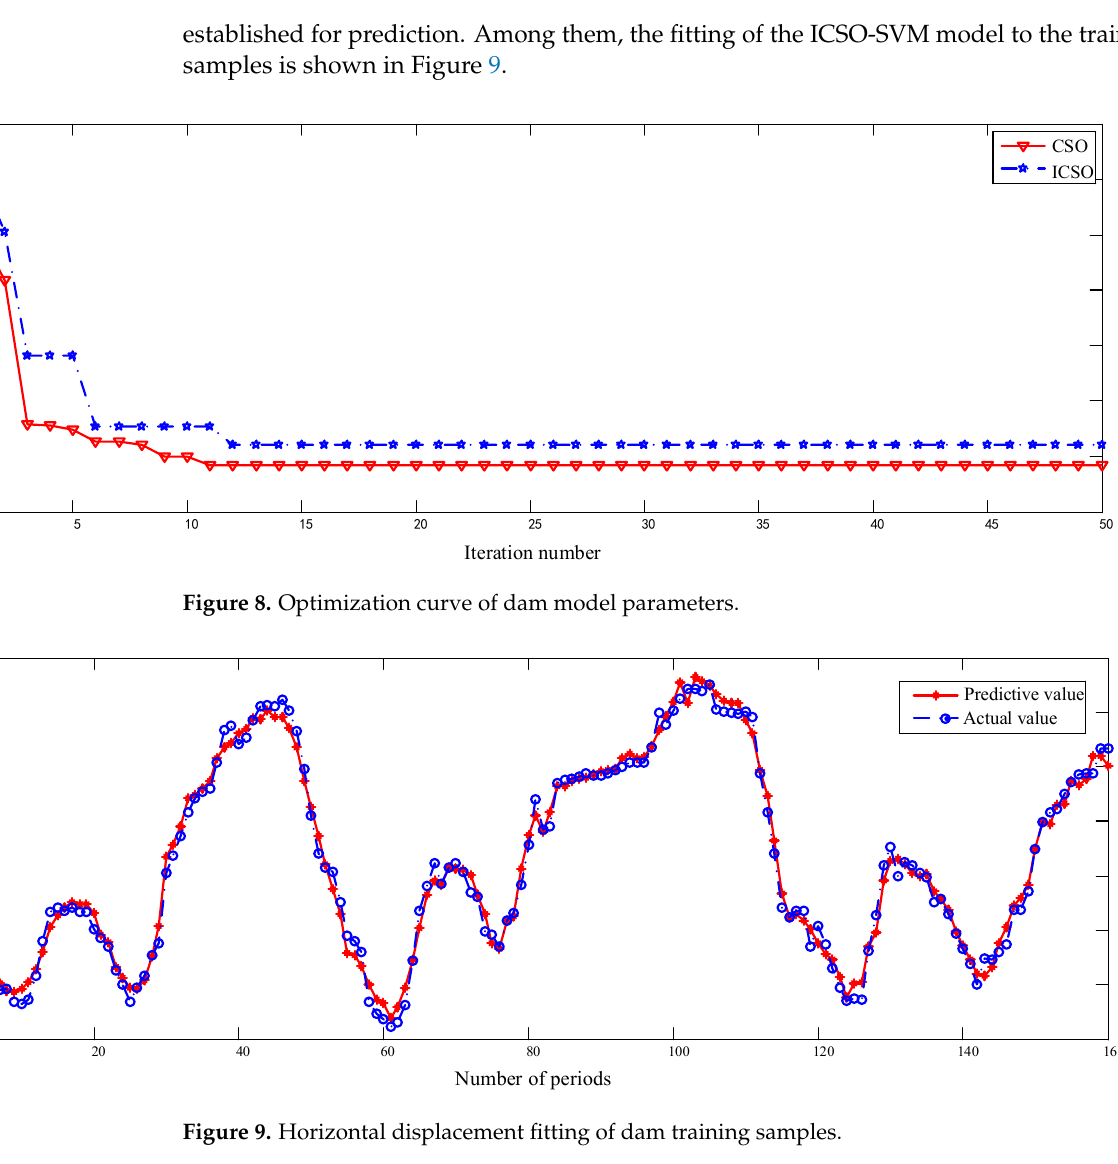
Figure 9. Horizontal displacement fitting of dam training samples.